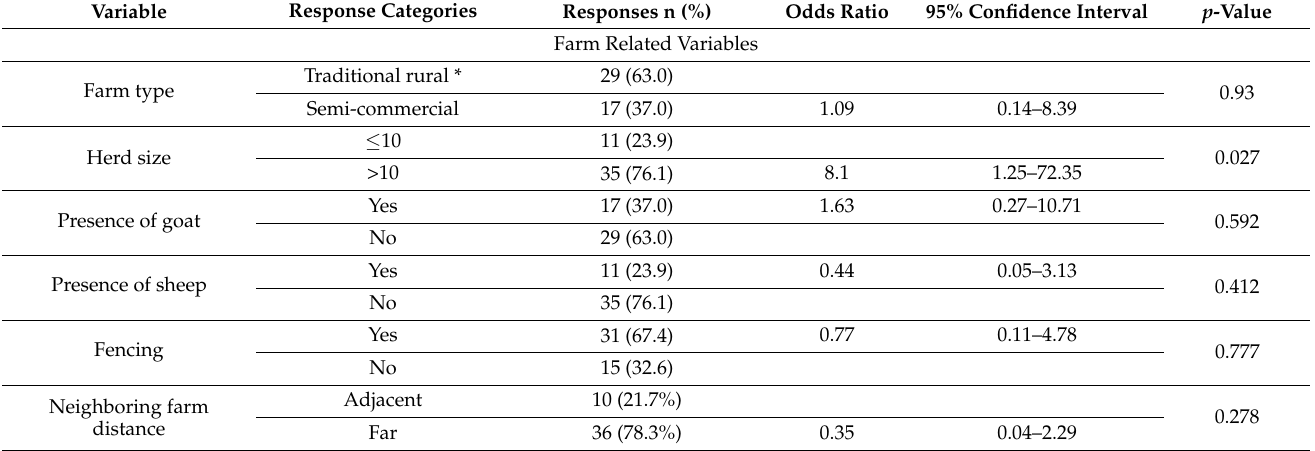
Table 3. Summary of the farm-level variables included in the initial multivariable